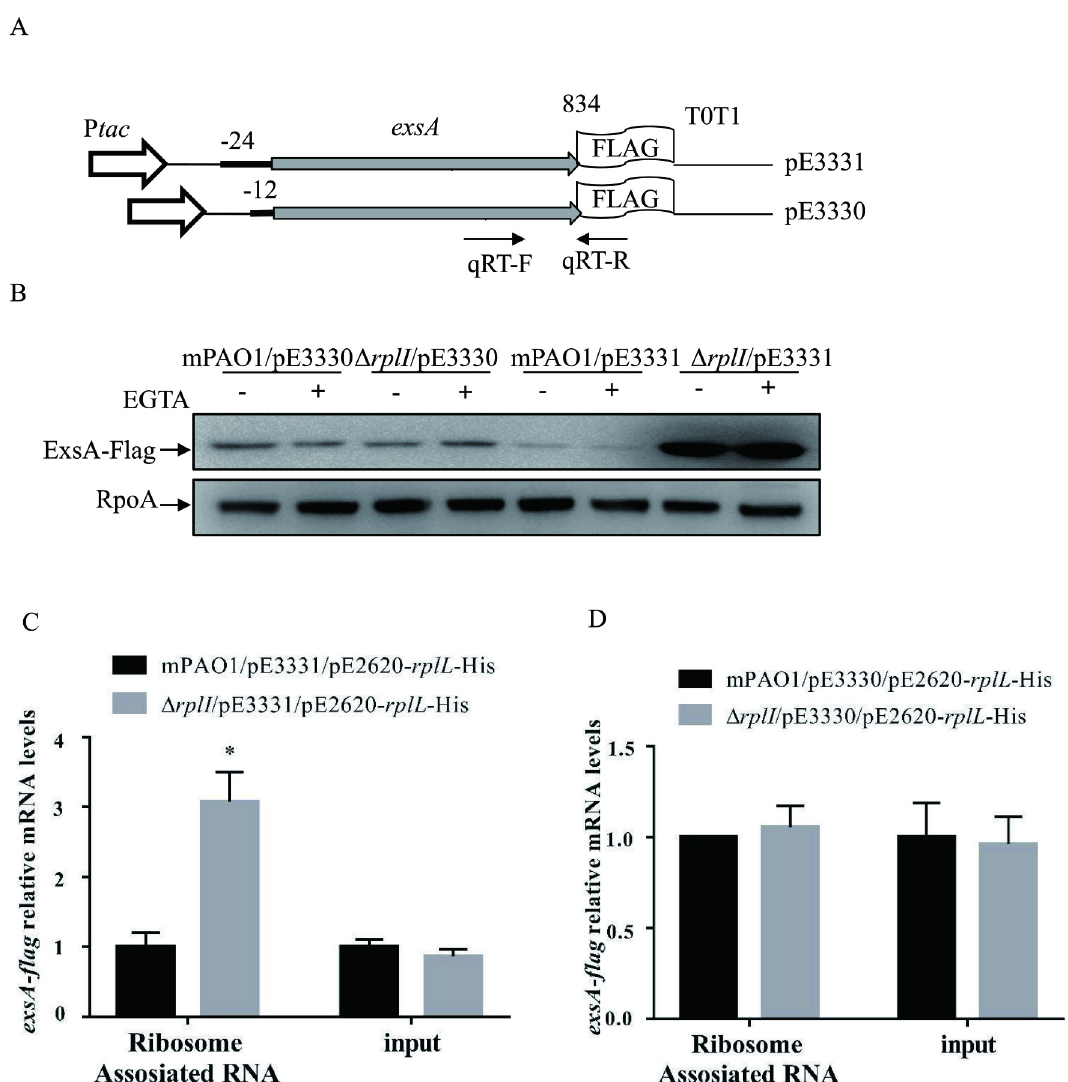
Fig 5. Expression of ExsA-Flag and quantification of ribosome-associated exsA mRNAs. (A) Constructs of P T0T1 (pE3331) and P tac -12 bp- exsA -Flag-T0T1 (pE3330). The positions of qPCR primers are represented by arrows. (B) The protein levels of ExsA-Flag in the indicated strains. mPAO1 and Δ rplI containing pE3330 or pE3331 were grown to an OD 600 of 1.0 in LB with (+) or without (-) 5 mM EGTA and collected by centrifugation. Samples from equivalent numbers of bacterial cells were loaded onto an SDS-PAGE gel and probed with an anti-Flag or an anti-RpoA antibody. The data shown represent the results from three independent experiments. (C and D) mPAO1 and Δ rplI containing pE2620- rplL -His and pE3331 (C) or pE3330 (D) were lysed with sonication and subjected to Ni-NTA chromatography or not (input), followed by RNA purification. The relative mRNA levels of exsA -Flag were determined by real-time qPCR with 16S ribosome RNA (PA0668.1) as the internal control. � , P < 0.05 by Student’s t test.